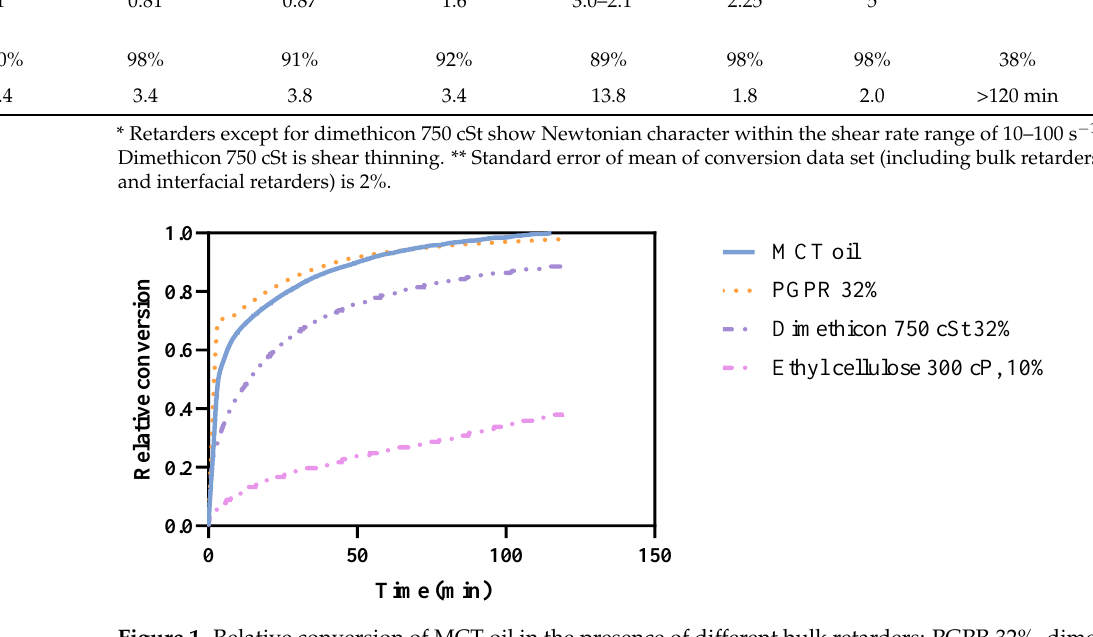
Figure 1. Relative conversion of MCT oil in the presence of different bulk retarders: PGPR 32%, dimethicon 750 cSt 32%, ethylcellulose 300 cP 32%. The curve is a mean value of duplicate measurements. The relative standard error of the method is 1.2%.